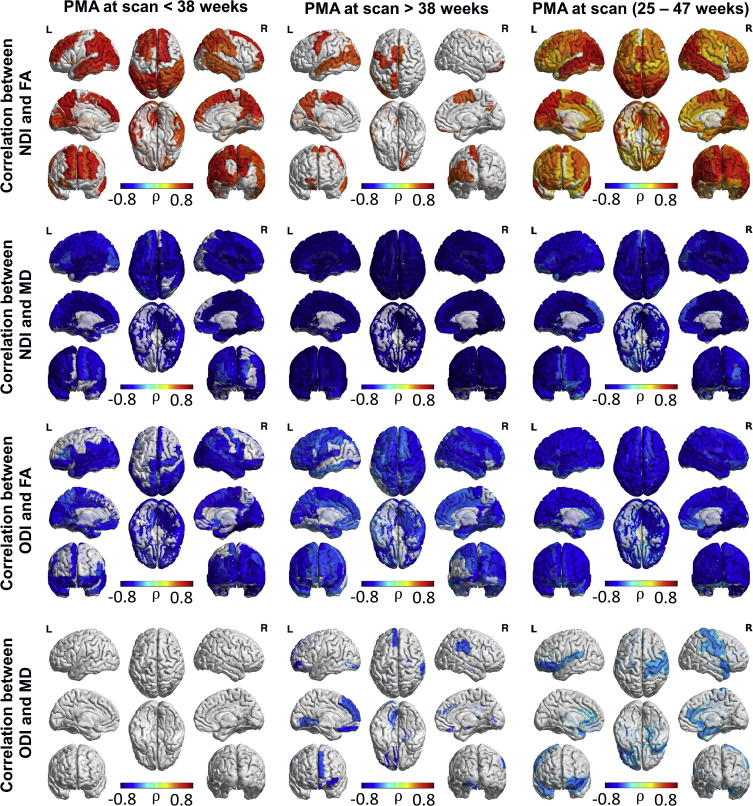
ROI-wise Spearman partial correlation between DTI and NODDI features (FDR corrected at 5%)